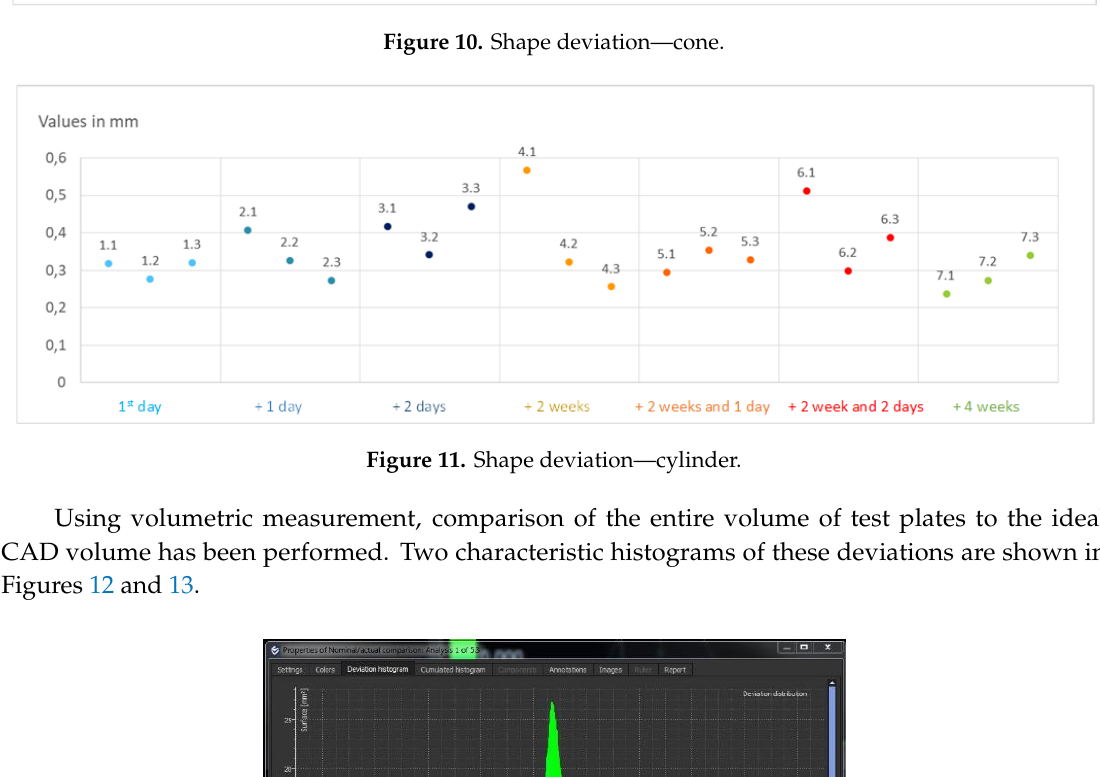
Figure 10. Shape deviation—cone.